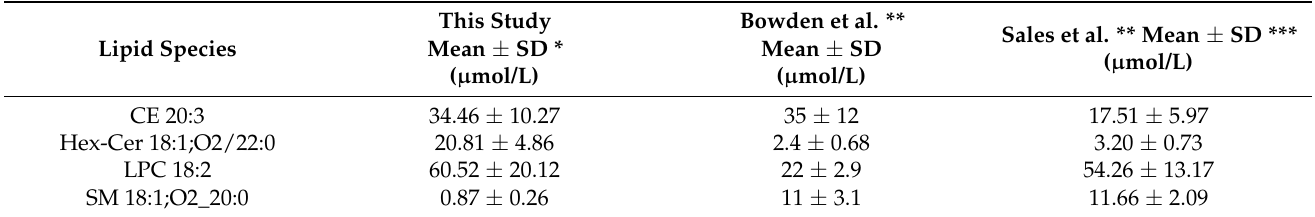
Table 5. Comparison of the concentrations of lipid species measured in different